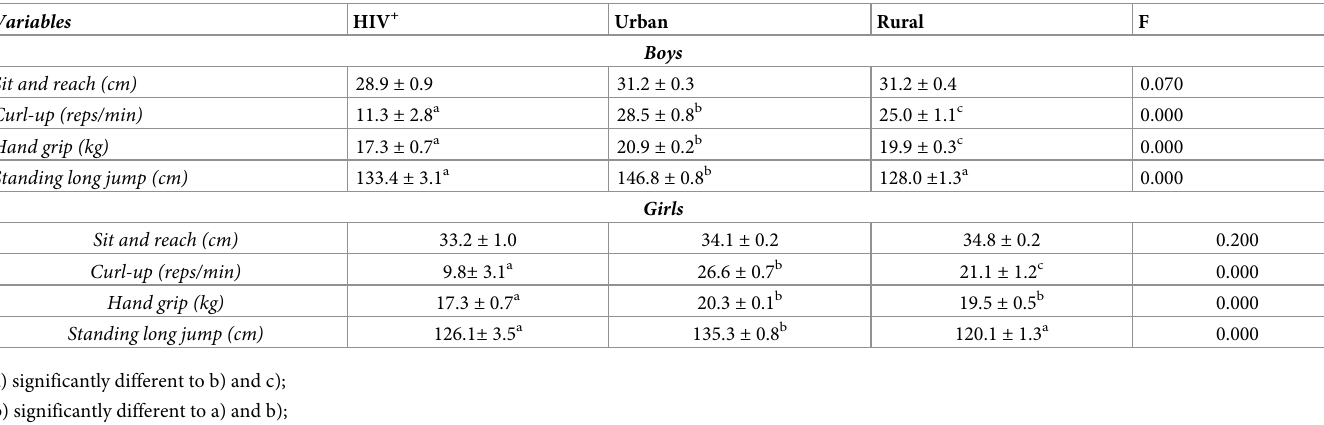
Standing long jump